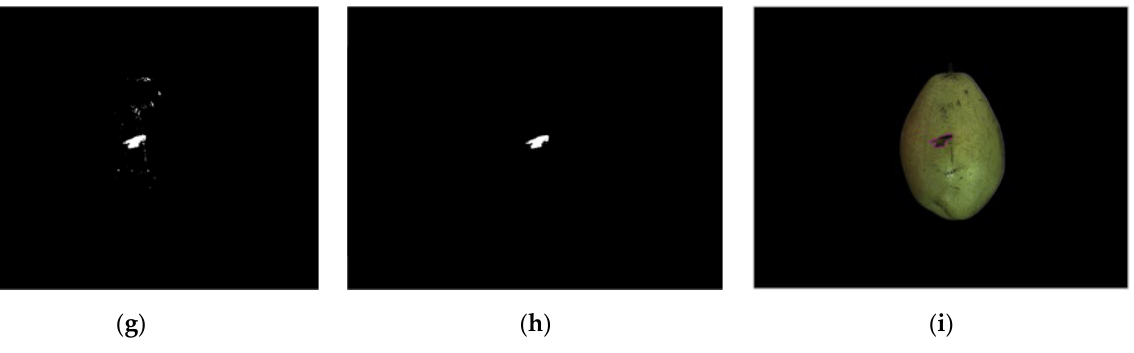
Figure 15. Image preprocessing process. ( a ) The original image. ( b ) Grayscale image of original image. ( c ) Pear contour image after threshold segmentation. ( d ) Pear contour image after morphological processing. ( e ) Segmented pear surface image. ( f ) Grayscale image of pear surface image. ( g ) Pear surface defect contour image after threshold segmentation. ( h ) Pear surface defect contour image after morphological processing and contour screening. ( i ) Pear surface defect image obtained after segmentation (contour indicated by red line).